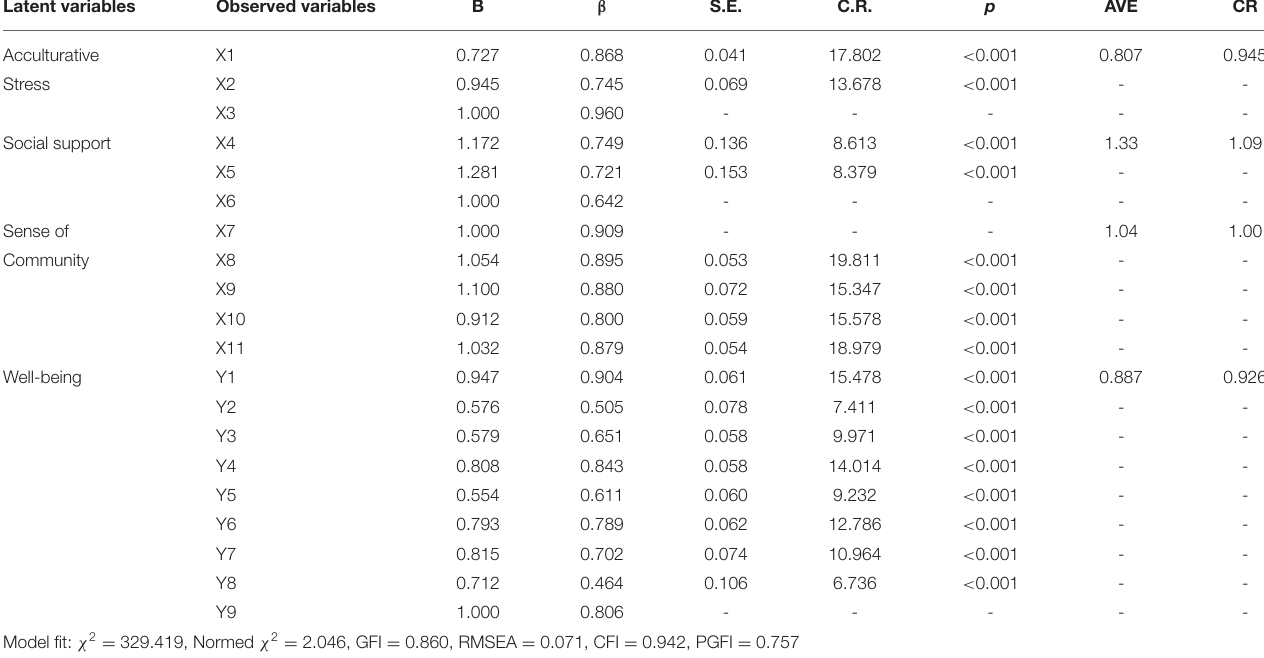
TABLE 2 | Factor loading of confirmatory factor